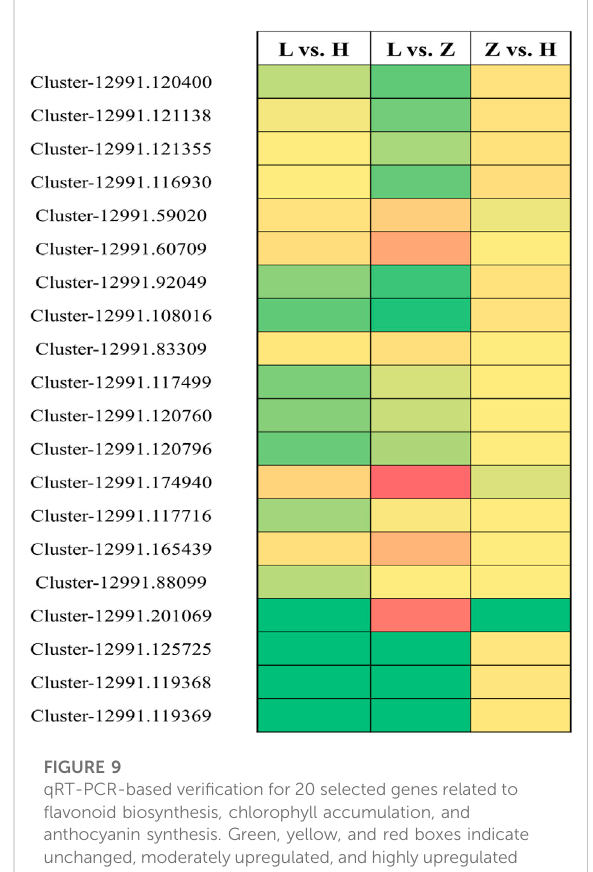
FIGURE 9 qRT-PCR-based veri fi cation for 20 selected genes related to fl avonoid biosynthesis, chlorophyll accumulation, and anthocyanin synthesis. Green, yellow, and red boxes indicate unchanged, moderately upregulated, and highly upregulated genes,